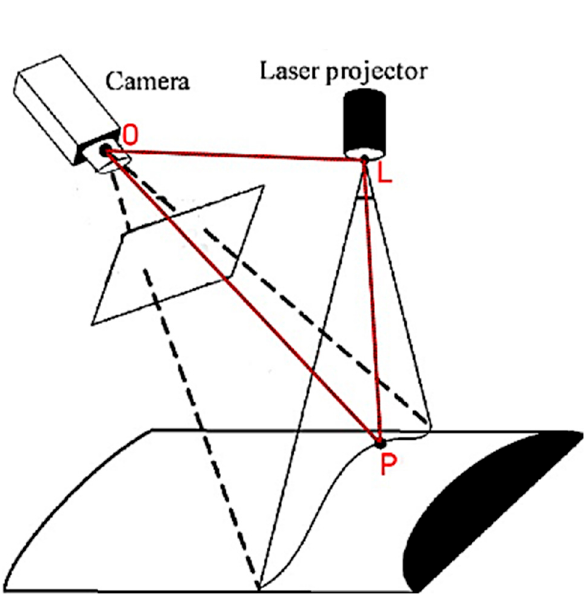
Figure 5. Triangulation method utilized in a structured light system for capturing the depth and texture [21].